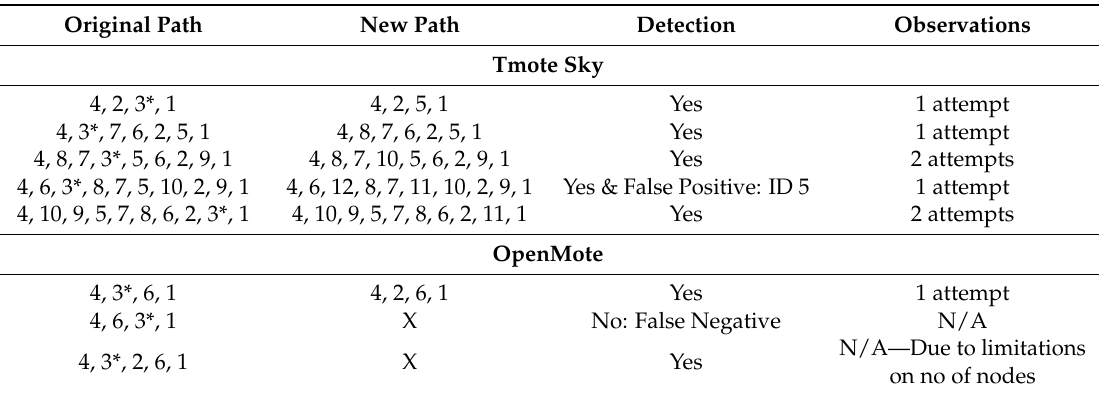
Table A1. Accuraccy check for single SF—nullrdc.